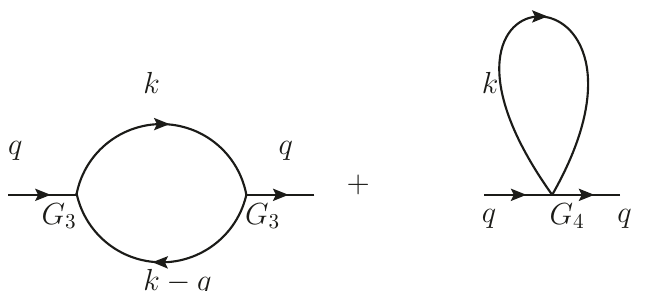
Figure 4. Diagrams that contribute at one loop order to the quadratic term (3.19) in the e(cid:11)ective